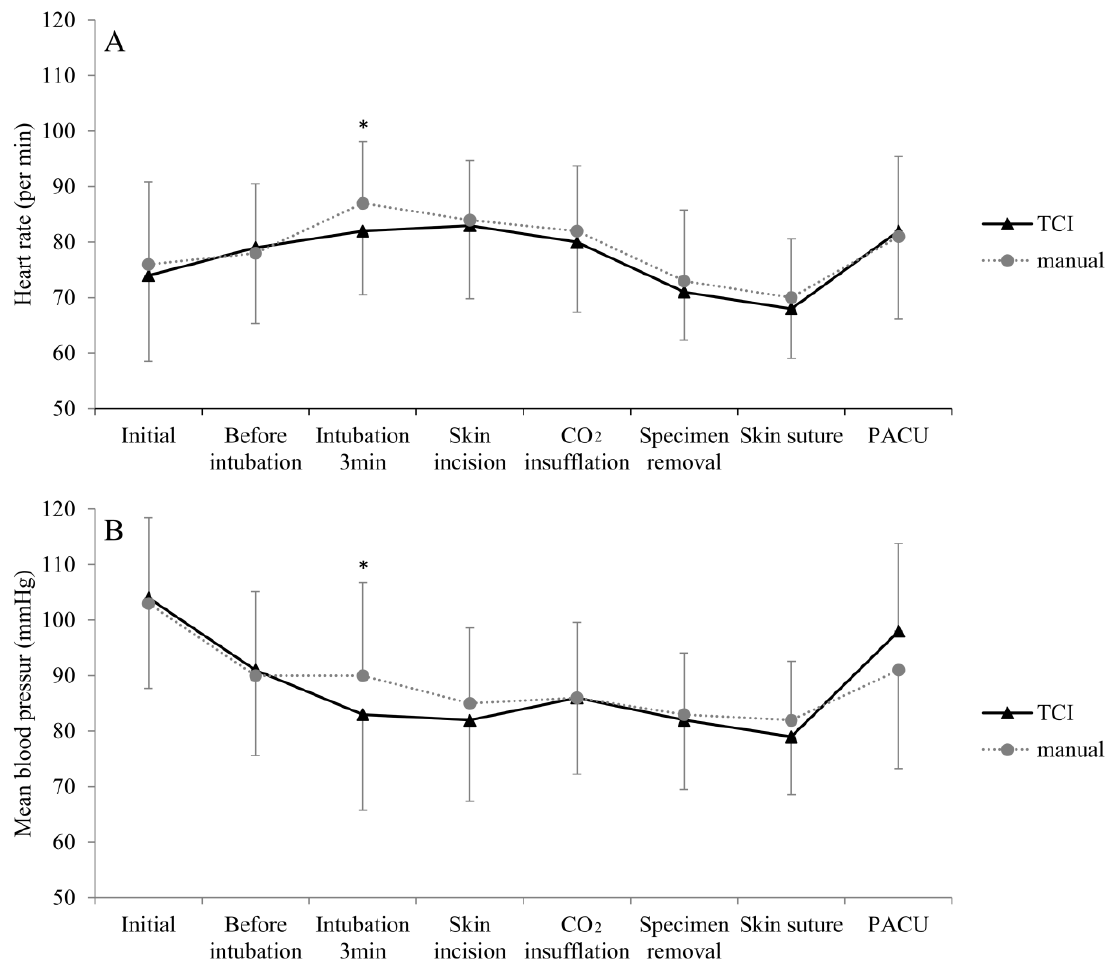
Figure 2. PONV incidence in total and different period. PONV, postoperative nausea and vomiting; TCI, target-controlled infusion; PACU, post-anesthetic care unit; POD, postoperative day.